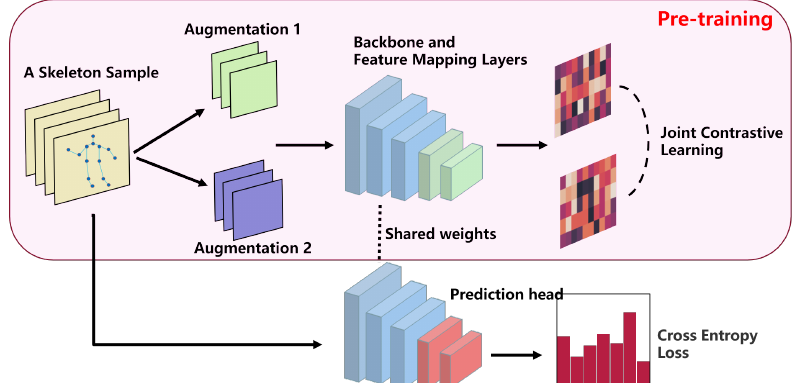
Figure 3. Our framework consists of two parts: pre-training and fine-tuning. In pre-training, two training samples are generated from each raw data by common data augmentation. With the help of IE-Graph, we feed the samples to the network to extract joint features and update the parameters using the proposed contrastive loss. In fine-tuning, the pre-trained weights are used as the initialization and are further refined on the target downstream task. In addition, we add a prediction head to complete the recognition.